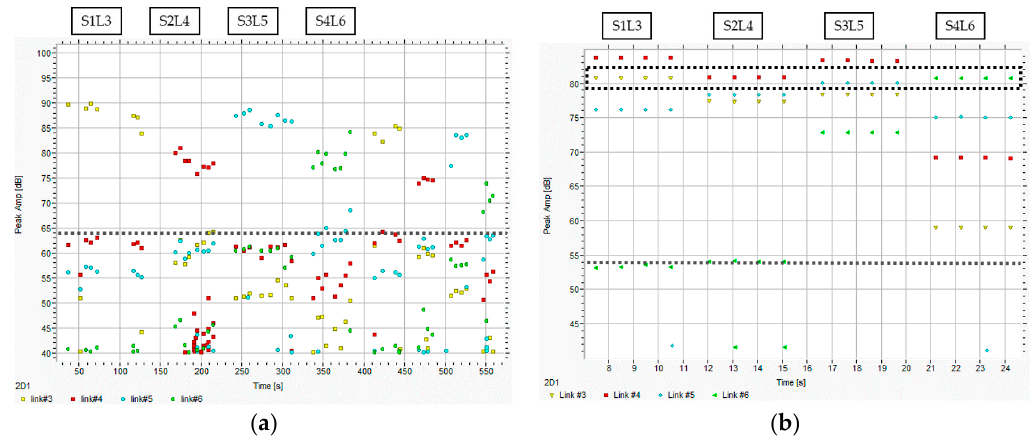
Figure 4. Calibration results for S1L3 (yellow), S2L4 (red), S3L5 (blue), and S4L6 (green) using ( a ) PLB and ( b ) the pulsing technique.